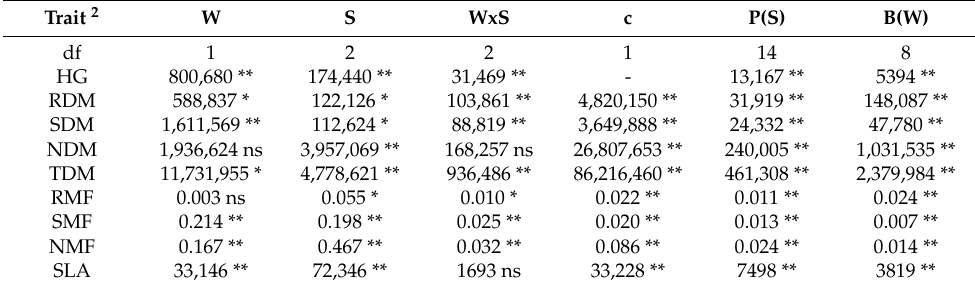
Table 2. Mean squares and level of significance 1 in the inter-specific analysis estimated for all species for different functional traits in three Mexican